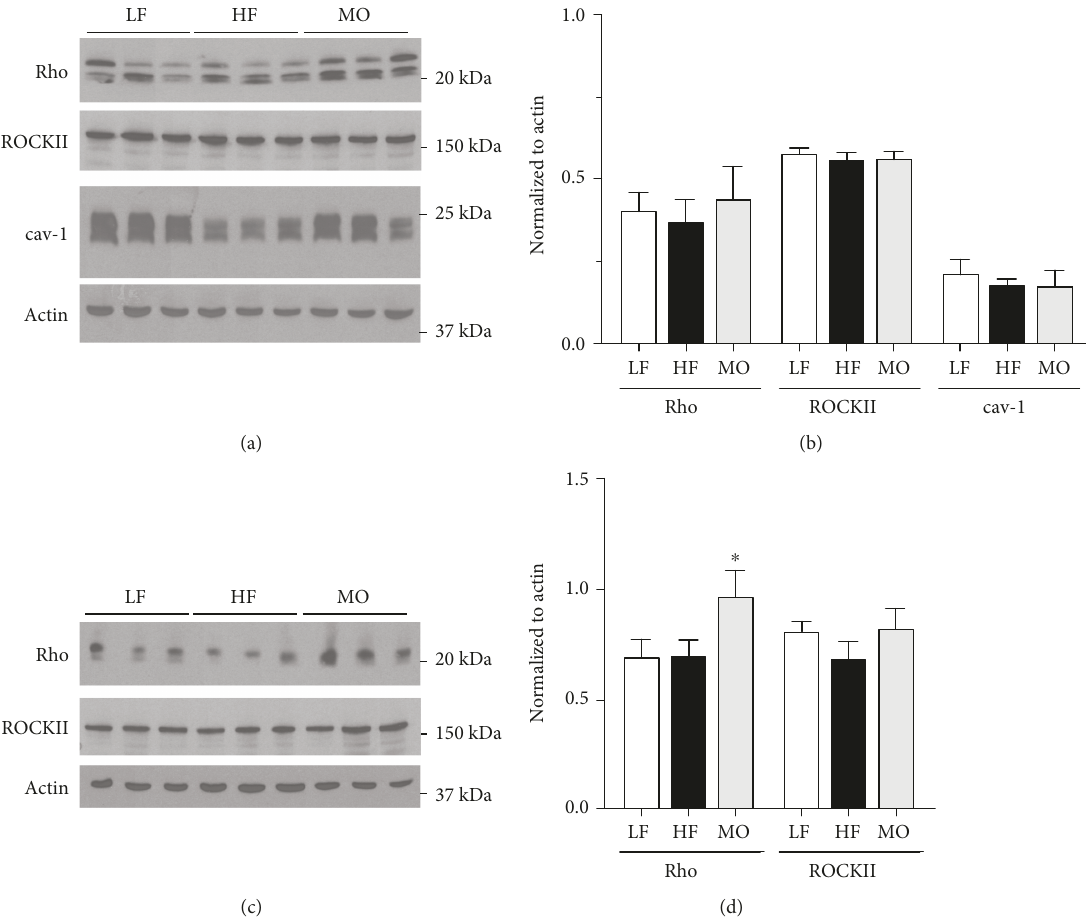
Figure 6: Representative and mean expression of rho, ROCK II, and cav-1 in the aorta from WT (a, b) cav-1 KO mice (c, d) on LF, HF, or MO diets. Mean ± SEM , n = 3 ‐ 9 per group, ∗ p < 0 05 vs. LF, HF, or MO diet. ANOVA followed by Tukey ’ s multiple comparison